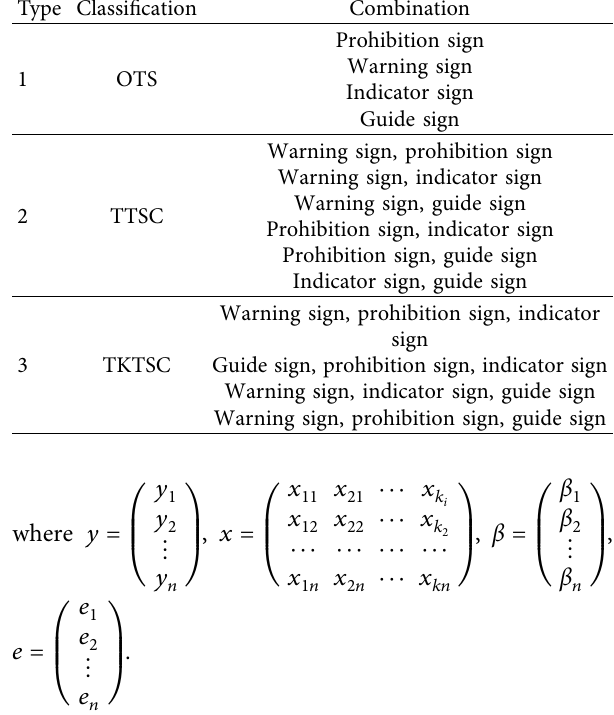
Figure 2: The driver’s information processing model in DTSC. Table 1: The various types of